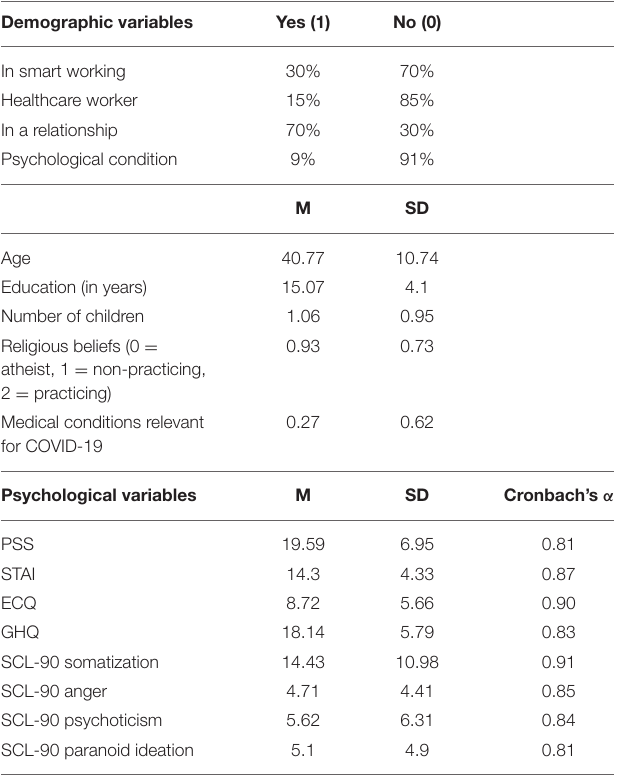
TABLE 1 | Descriptive statistics for the demographic and psychological variables ( N =